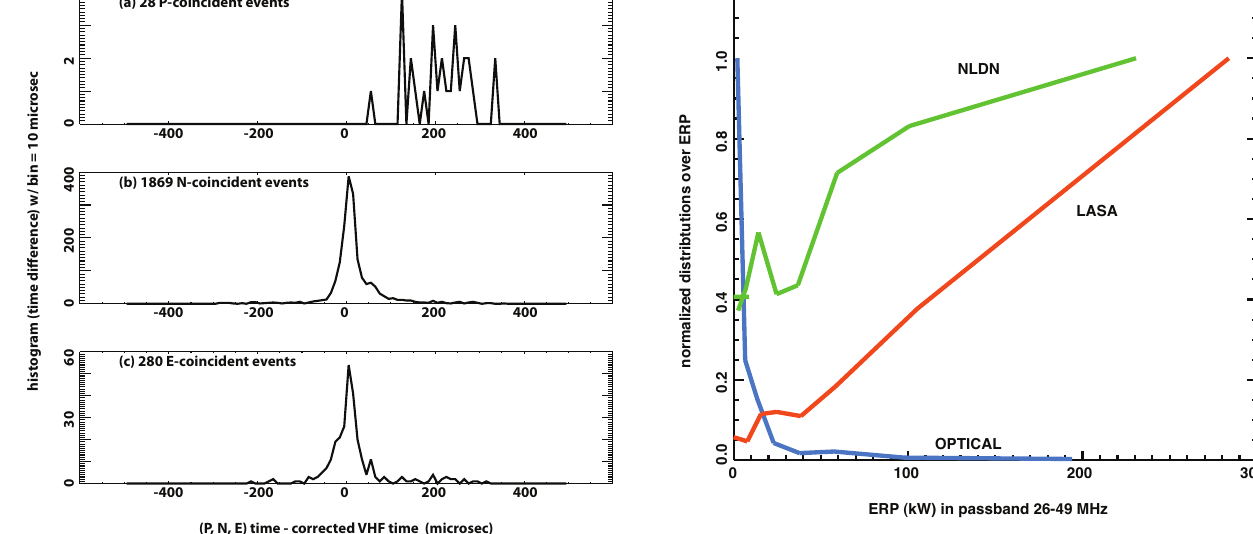
Fig. 10. Similar to Figs. 8 and 9, but for VHF events of highest power: 60 < ERP kW.